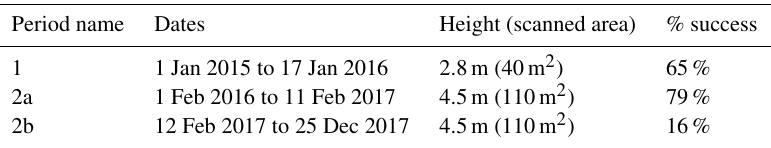
Table 1. RLS configuration and performance for different